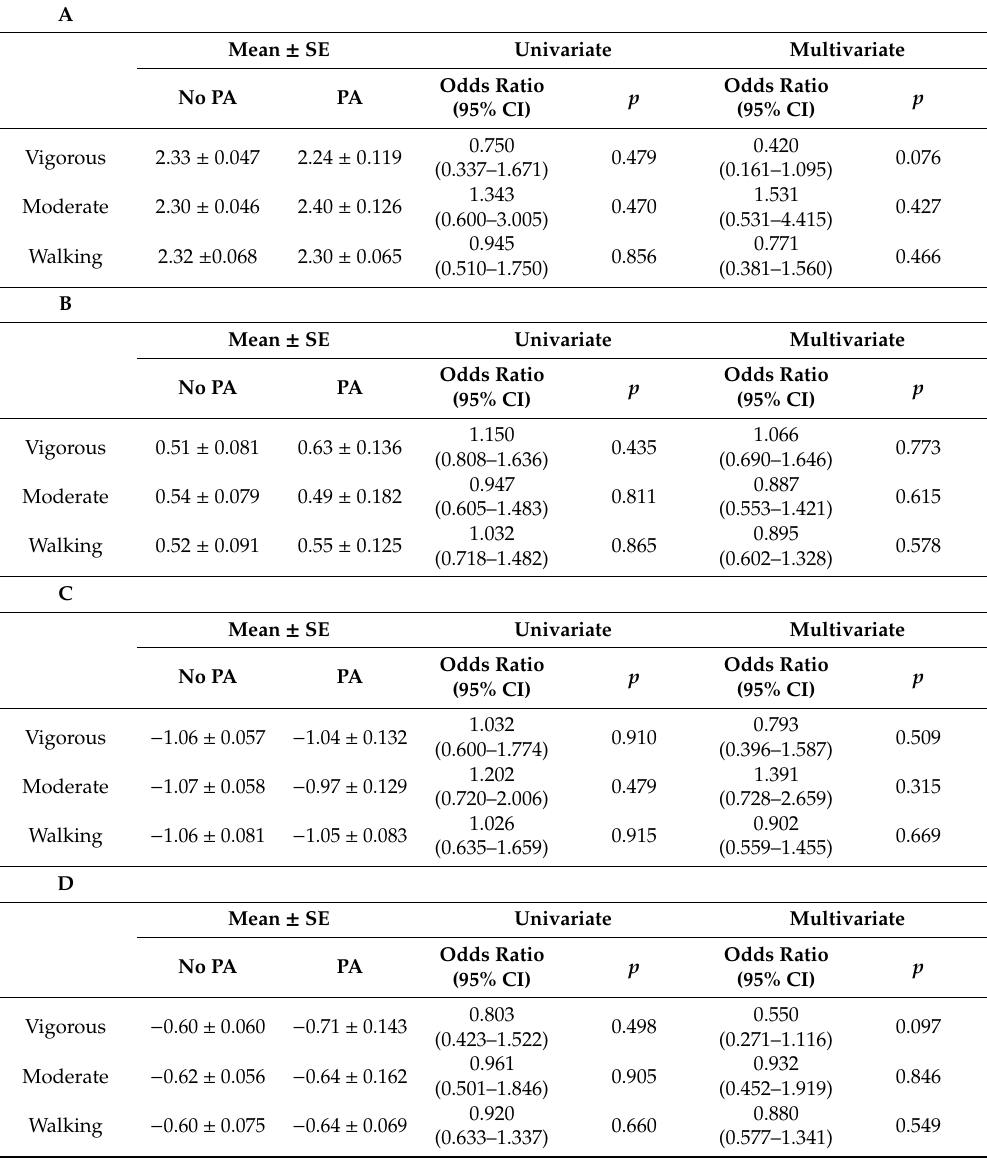
Table 5. Odds ratios for the associations between physical activity and (A) total, (B) D. farinae , (C) dog, and (D) cockroach IgE levels (log 10 transformed) in patients with allergic